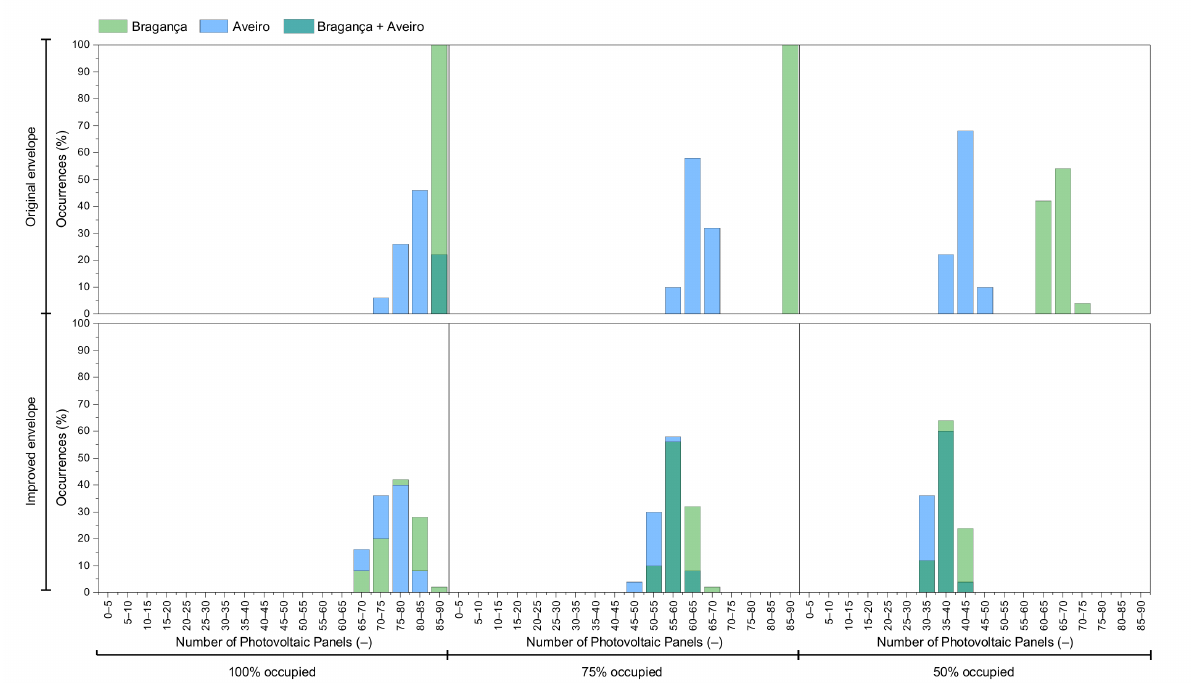
Figure 12. Envelope improvements analysis for heating system with COP of